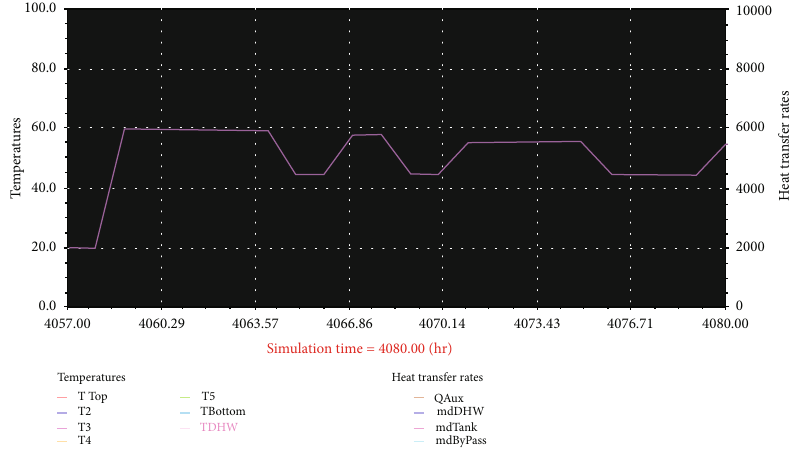
Figure 13: Hot water temperature produced by the solar water heater system on June